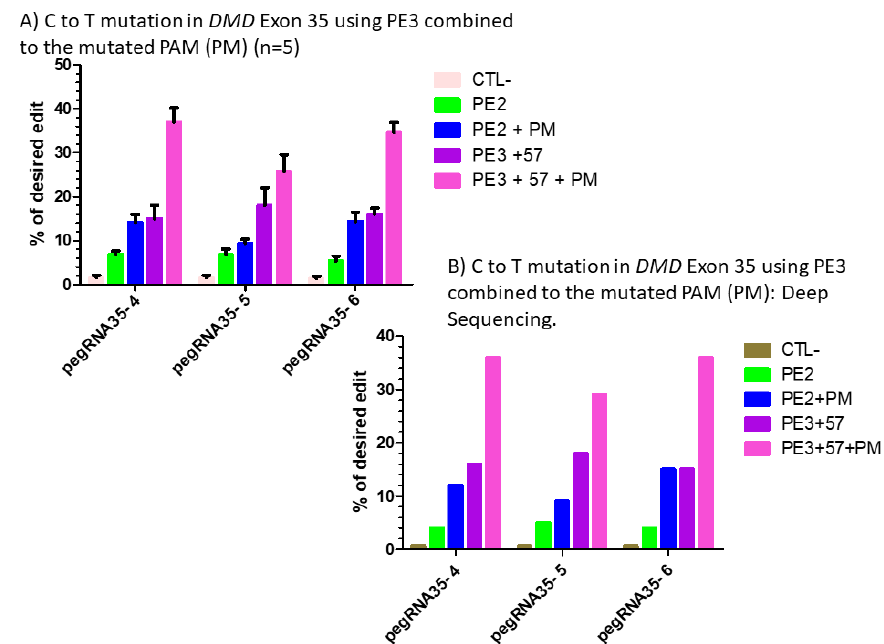
Figure 7. ( A ) prime editing of DMD exon 35 using the PE3 strategy combined with the mutation in the PAM (PM). There was a 1% background level of thymidine (T) in the position of the targeted nucleotide. However, the combination of PE3 using a sgRNA to induce a nick at +57 nucleotides from the pegRNA nick site with the mutation of the PAM sequence showed a significant increase from 6% with the PE2 technique to 38% with pegRNA35-4 (cid:48) , from 5% to 30% with pegRNA35-5 (cid:48) and from 4% to 39% with pegRNA35-6 (cid:48) . The experiments were carried out in five independent replicates ( n = 5). ( B ) prime editing of DMD exon 35 using the PE3 strategy combined with the mutation in the PAM (PM): deep sequencing results. There was a 1% background level of thymidine (T) in the position of the targeted nucleotide. However, the combination of PE3 using a sgRNA to induce a nick at +57 nucleotides from the pegRNA nick site and the mutation of the PAM sequence showed a significant increase from 4% with the PE2 technique to 38% with pegRNA35-4 (cid:48) , from 5% to 29% with pegRNA35-5 (cid:48) and from 4% to 36% with pegRNA35-6 (cid:48) . This deep sequencing experiment was done only once ( n =